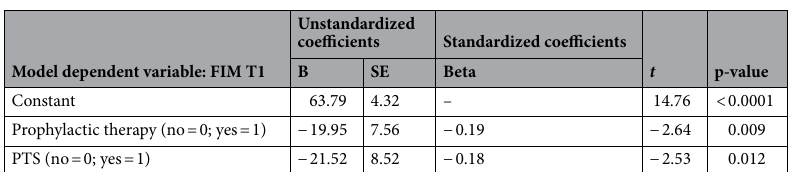
Table 6. Multiple linear regression analysis showing independent predictors for FIM at discharge (T1). FIM functional independence measure, PTS post-traumatic seizures, T1 at discharge.